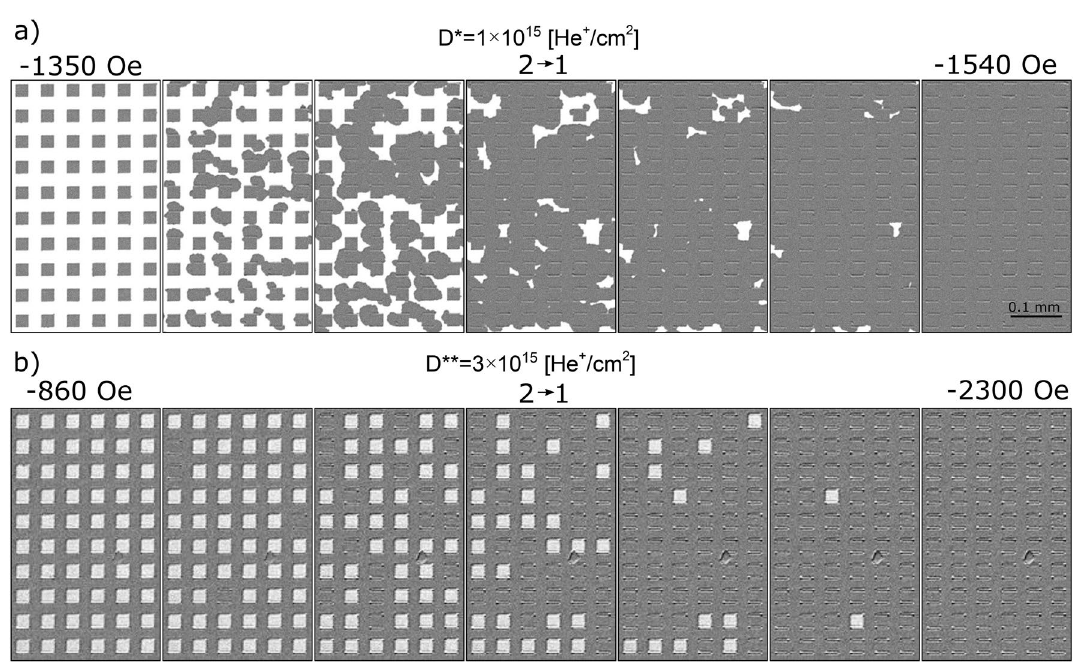
Figure 7. Magnetization reversal of squares in the lattice with a = 25 μm (sample B2), corresponding to the transition 2 → 1 for lattice patterned with ( a ) D* = 1 × 10 15 He + /cm 2 and ( b ) D** = 3 × 10 15 He + /cm 2